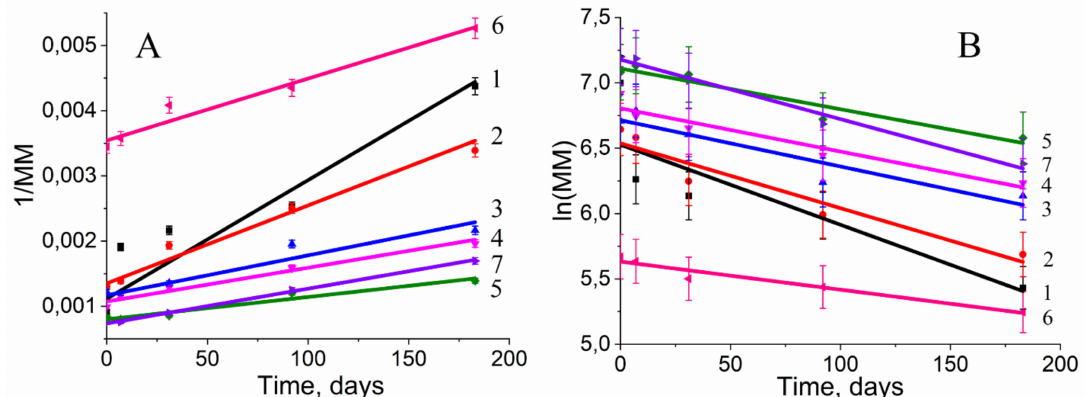
Figure 3. Model of not autocatalytic degradation ( A ) and autocatalytic degradation ( B ), constructed on the basis of the results of changes in the molecular mass of polyhydroxyalkanoates (PHA) in the process of hydrolytic degradation. 1 – PHB 1095, 2 – PHBV 2.5% 768, 3 – PHBV 5.9% 819, 4 – PHBV 9% 1010, 5 – PHBV 17.6% 1190.